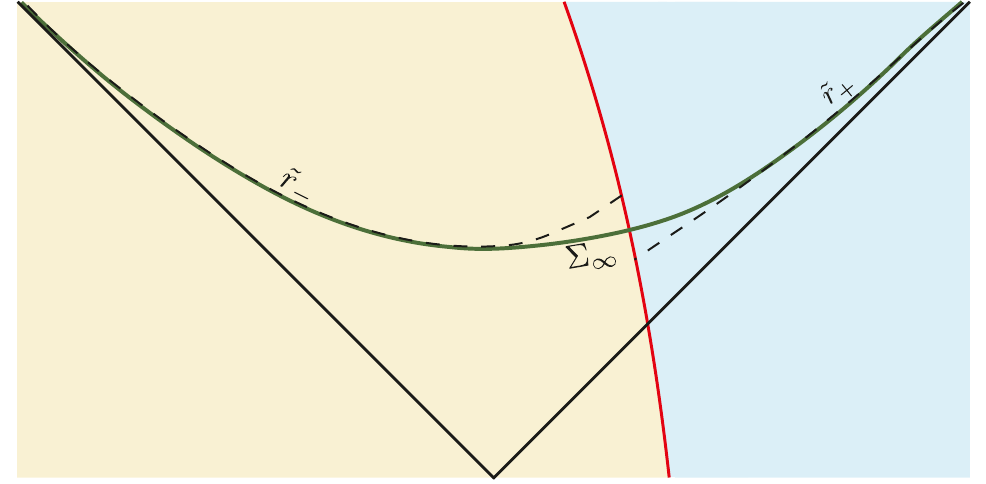
Figure 5 . The saturation slice (cid:6) 1 interpolates between the extremal surface barrier inside ~ r (cid:0) and outside ~ r +